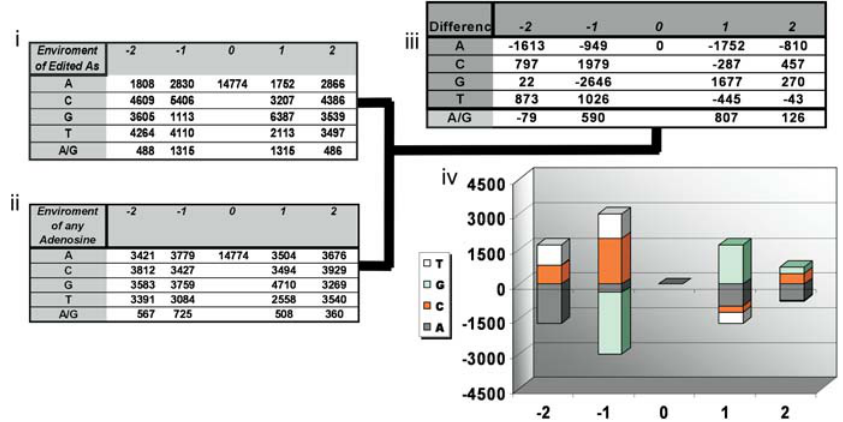
Figure 9. Cis Preferences of Editing Sites in Alus Tables (i) and (ii) show the frequency of A, G, C, T, or an A/G editing site at positions (cid:1) 2, (cid:1) 1, 1, and 2 relative to each of the 14,774 AtoG mismatch sites found within the high confidence group of Alu elements (i) and in relation to a ran- domly chosen adenosine from each of the those sequences for each AtoG mismatch (ii). Table (iii) shows relative editing preferences after bias removal by subtracting table (ii) from Table (i). (iv) Graphical representation of Table (iii). DOI: